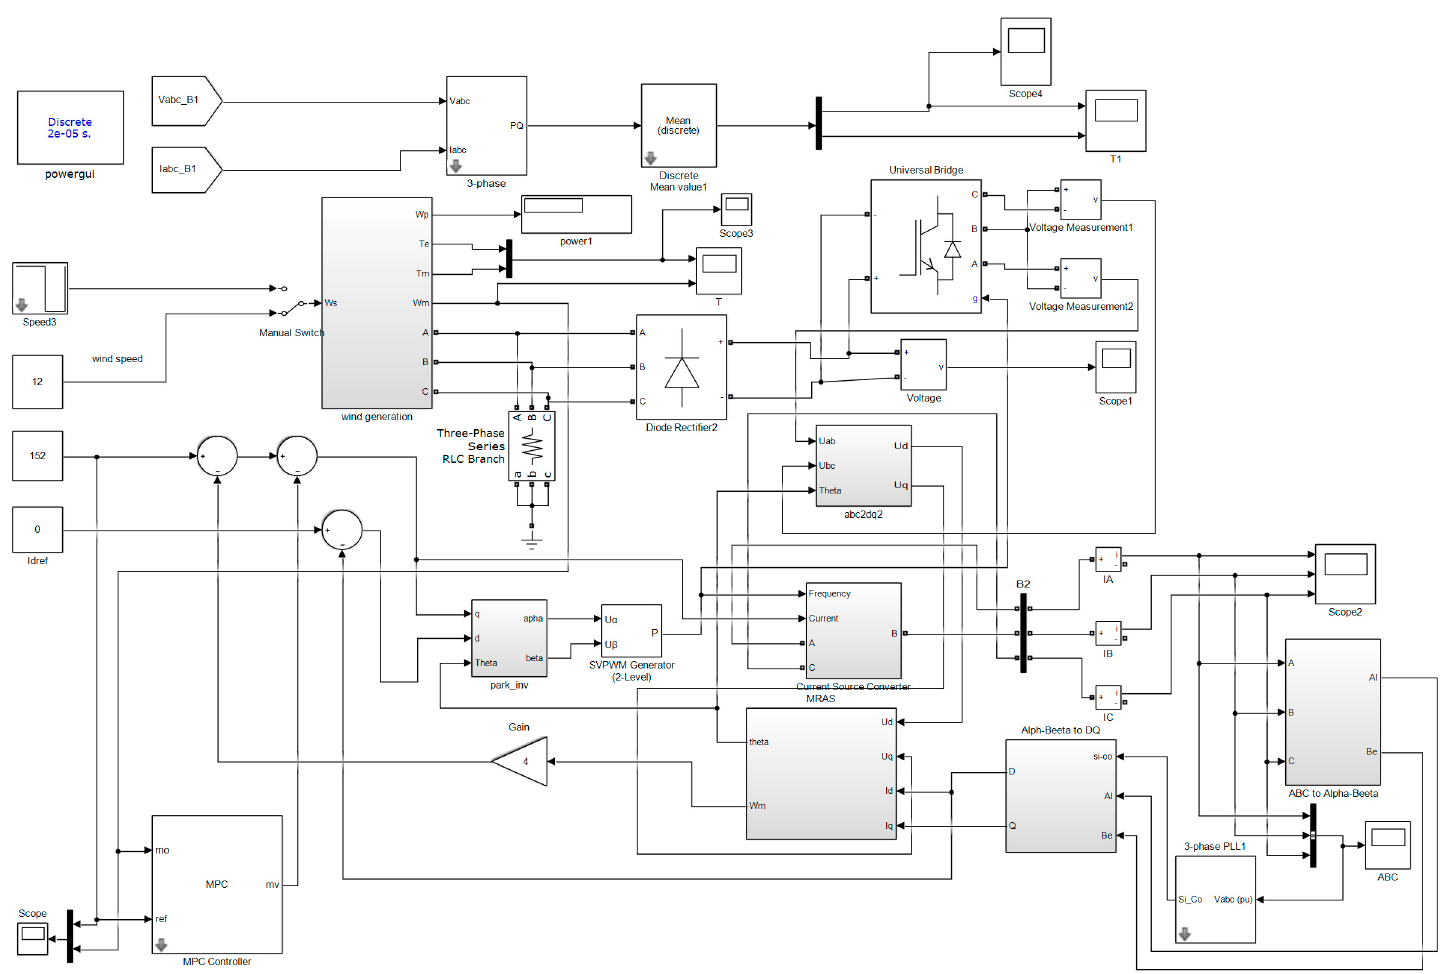
Figure 6. The proposed adaptive control method for the variable speed PMSG based on PWM-CSC.